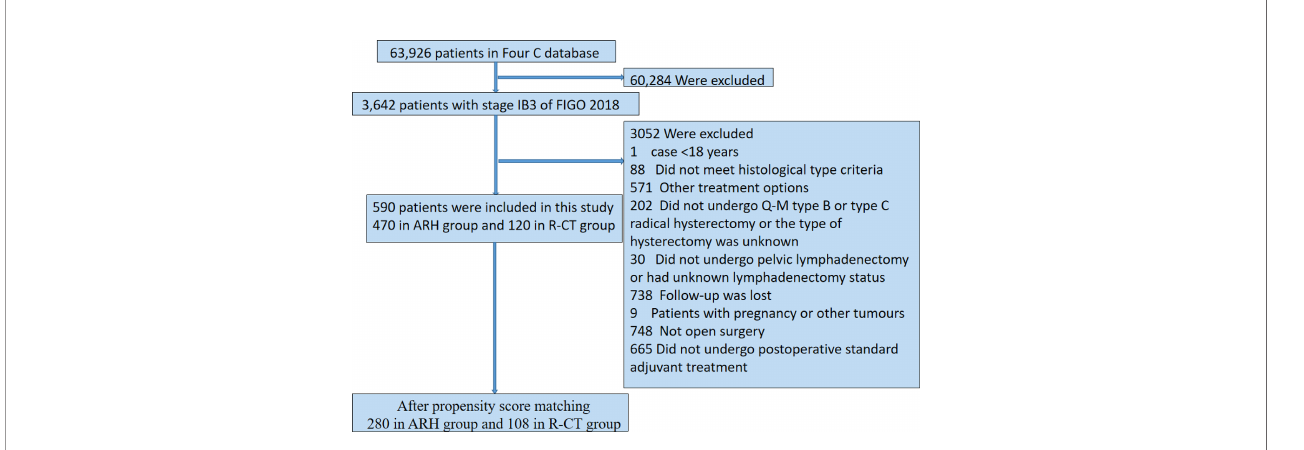
FIGURE 1 | Flow diagram of recruitment and exclusions. ARH, abdominal radical hysterectomy; R-CT, radio-chemotherapy.